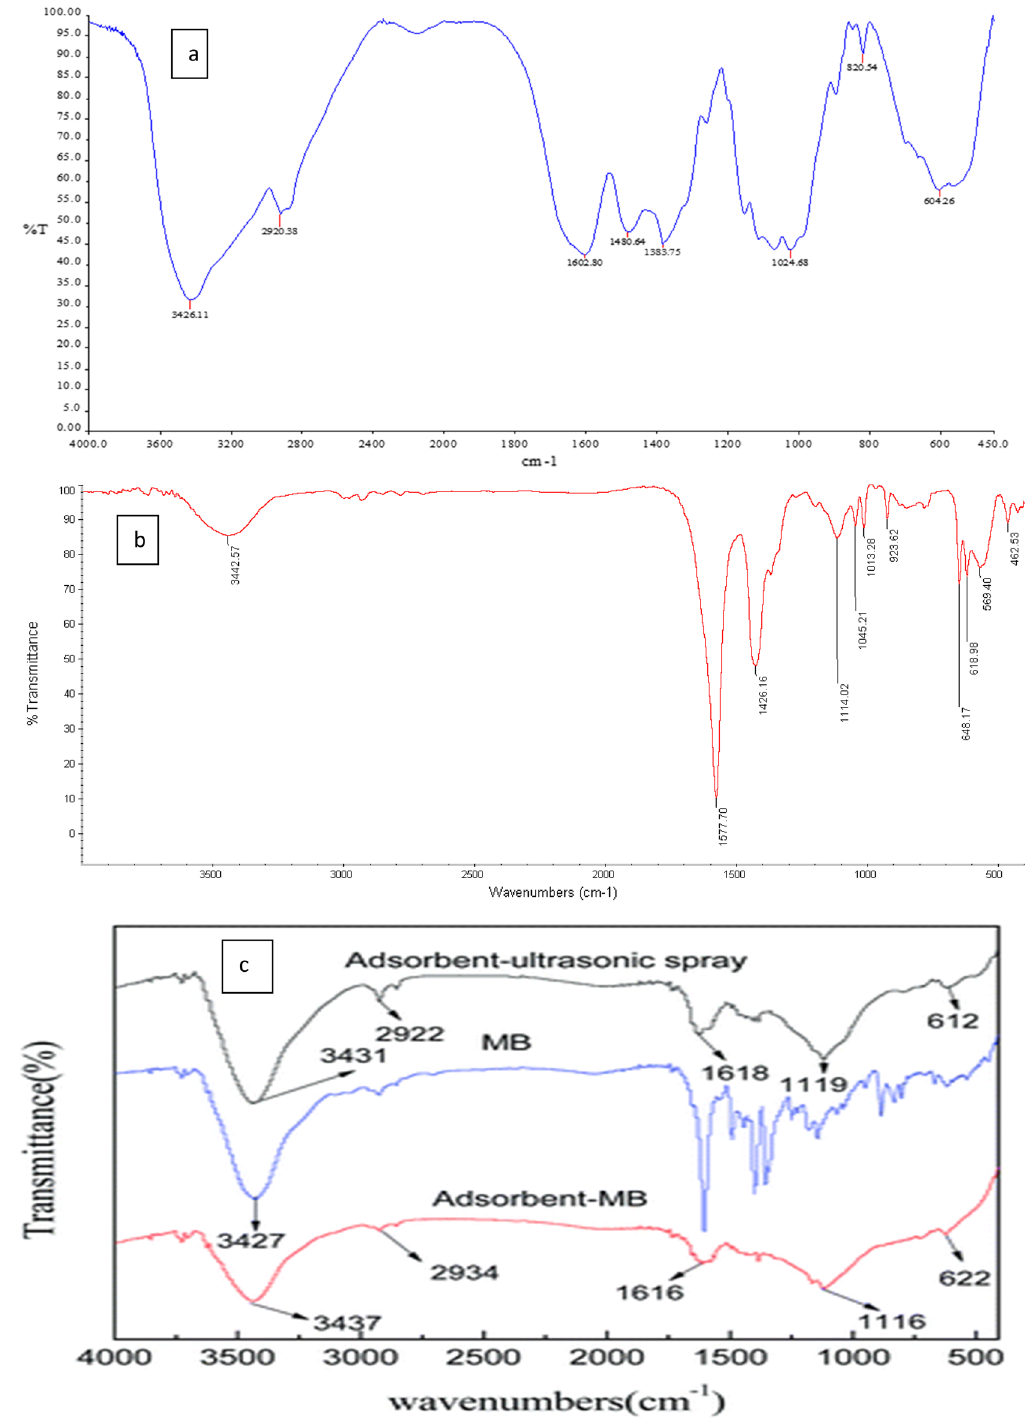
Figure 1. The FT-IR spectrum of the Ni 0.5 Co 0.5 Fe 2 O 4 @AC/Ch nanobiocomposite ( a ) Before adsorption ( b ) after adsorption ( c ) The FT-IR spectrum of the Methylene blue 22 FESEM and element EDAX analyses of the magnetic nanobiocomposite. Figure 2 represents the FESEM of the magnetic nanobiocomposite at 100, 200, 1000, and 10,000 nm magnifications. According to these images, the particle sizes are about 16.64 nm, and the ferrite nickel–cobalt particles are present as small bulks on the acti- vated carbon surface. Element EDAX analysis is shown in Fig. 3, according to which, the ratios of Fe, Co, Ni, C, and O are consistent with the used ratios, indicating the high purity of 99% the of nanobiocompo-site. These two analyzes show the effect of the use of stabilizers and the quality of the raw materials.